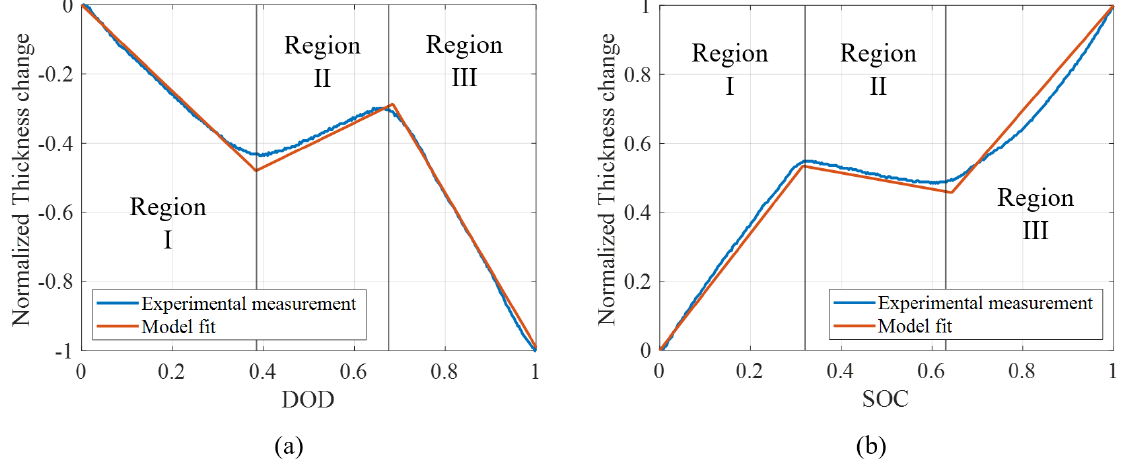
Figure 11. Comparison between the fitted model and experimental measurements in discharge ( a ) and charge ( b